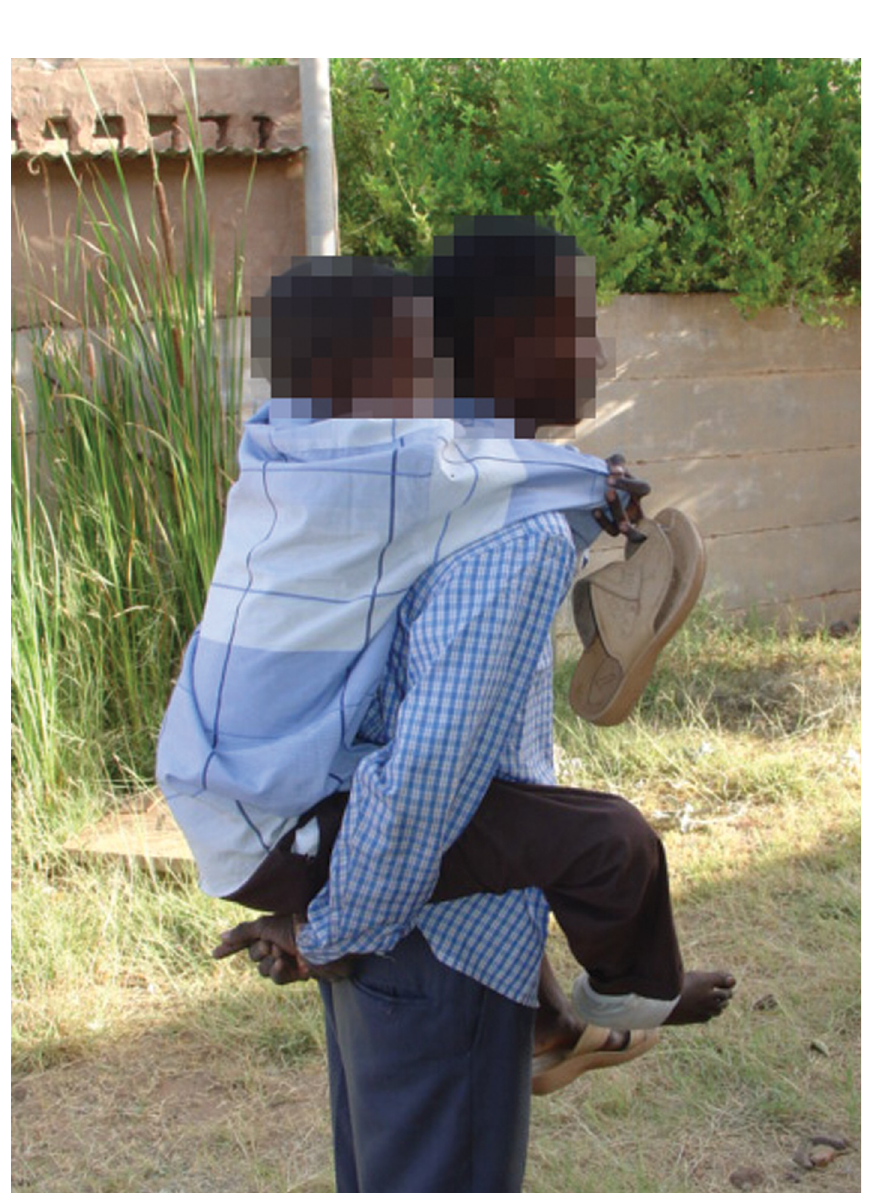
Fig 2. A patient carried consistently by his brother due to